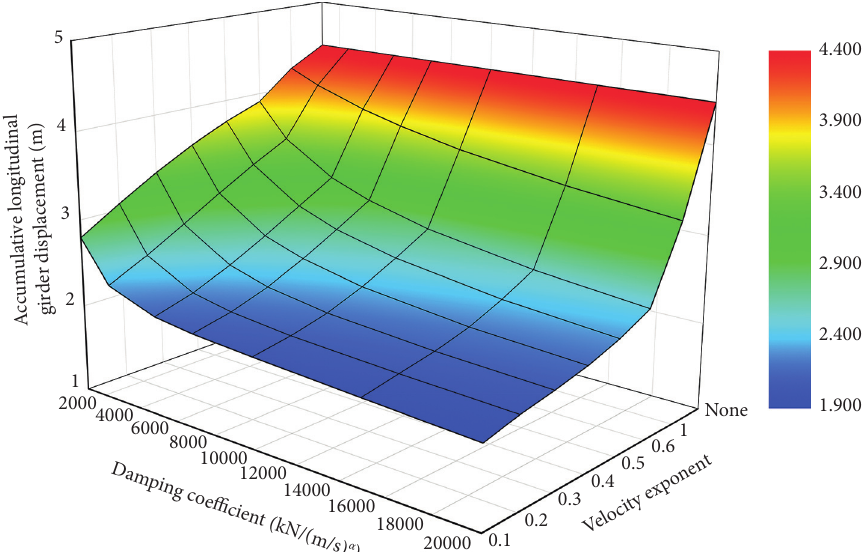
Figure 16: Accumulative longitudinal girder displacement W